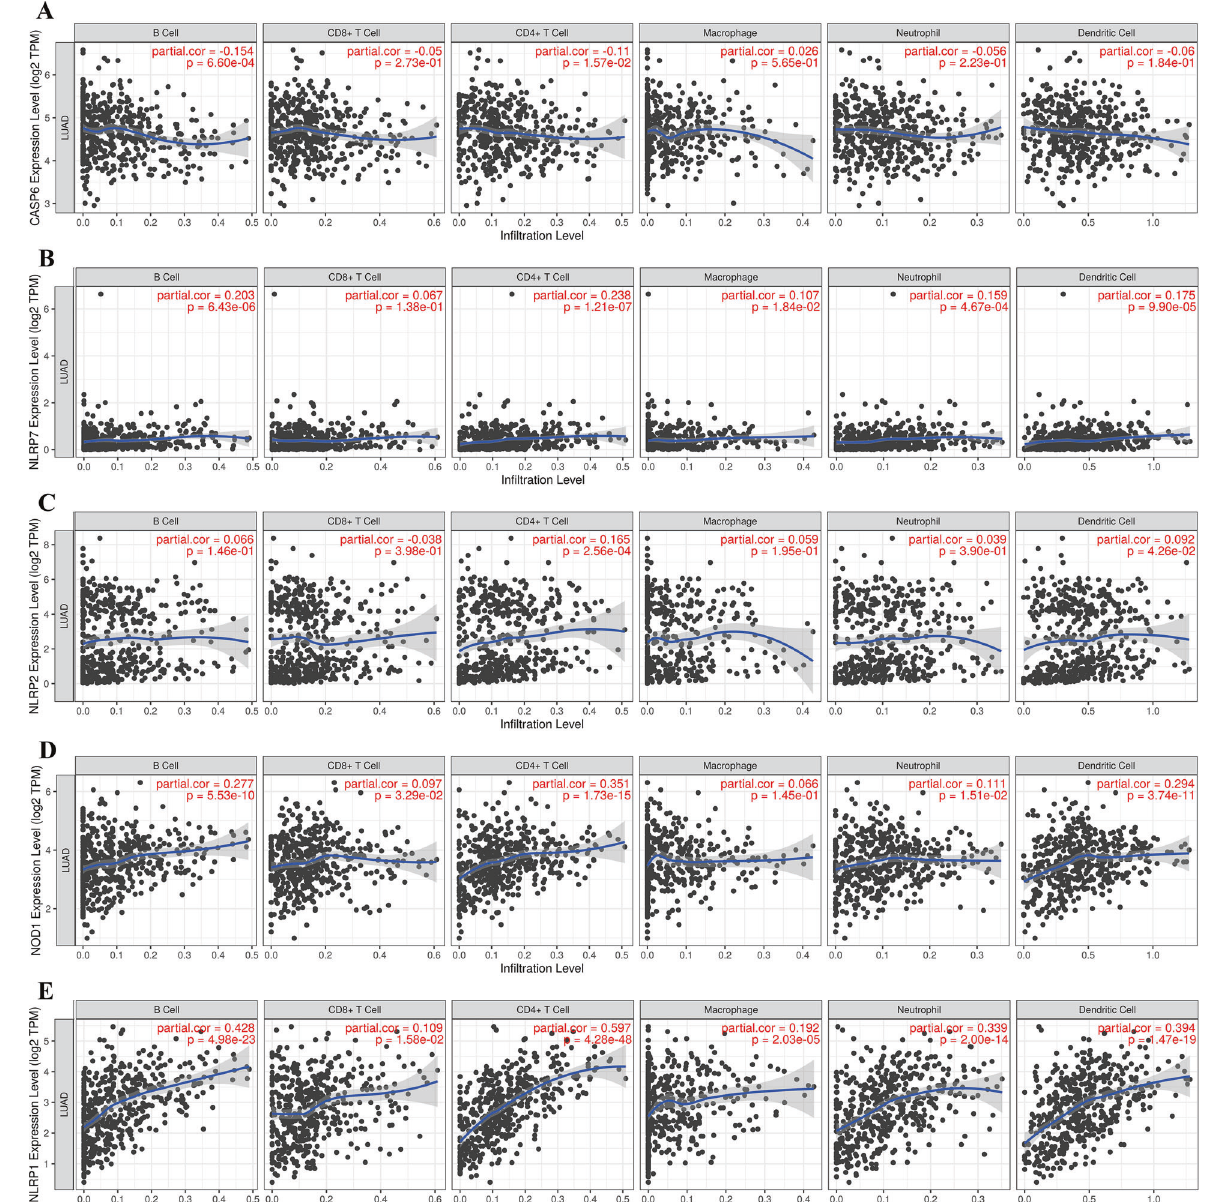
Fig. 6 The association between fi ve prognostic PRG and immune in fi ltration (TIMER). The association between the abundance of immune cells and the expression of CASP6 A NLRP7 B NLRP2 C NOD1 D and NLRP1 E in LUAD. PRG pyroptosis ‑ related gene, LUAD lung